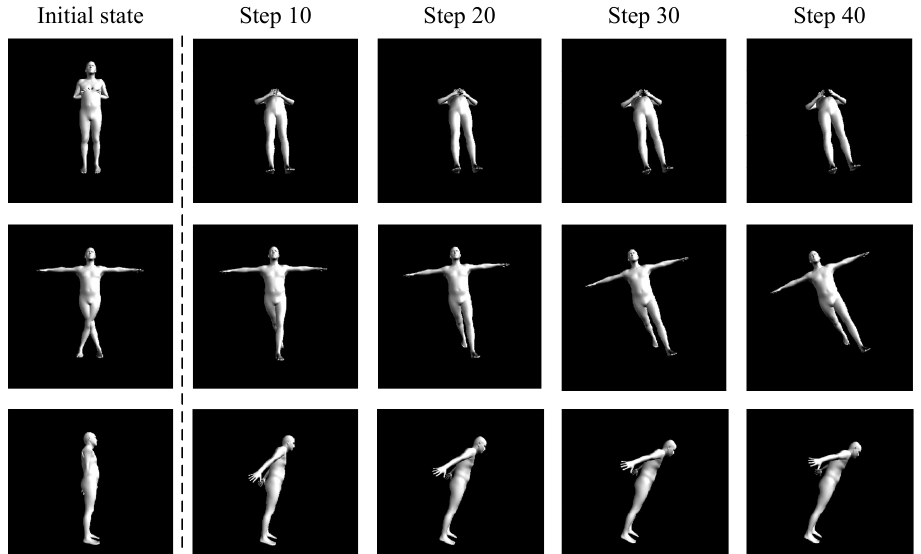
Figure 7. Images rendered from the iterative process without gradient normalization. First column: images rendered from initial meshes with self-intersection. Second through fourth columns: images rendered from optimized meshes every 10 steps.